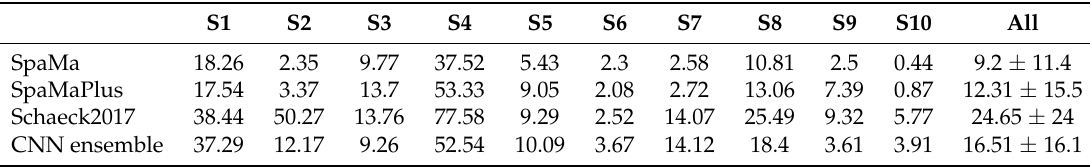
Table 8. Session-wise evaluation results on the dataset IEEE_Test , achieved with the three classical methods and the best performing CNN architecture (ensemble prediction). Results are given as MAE [bpm]. S1 S2 S3 S4